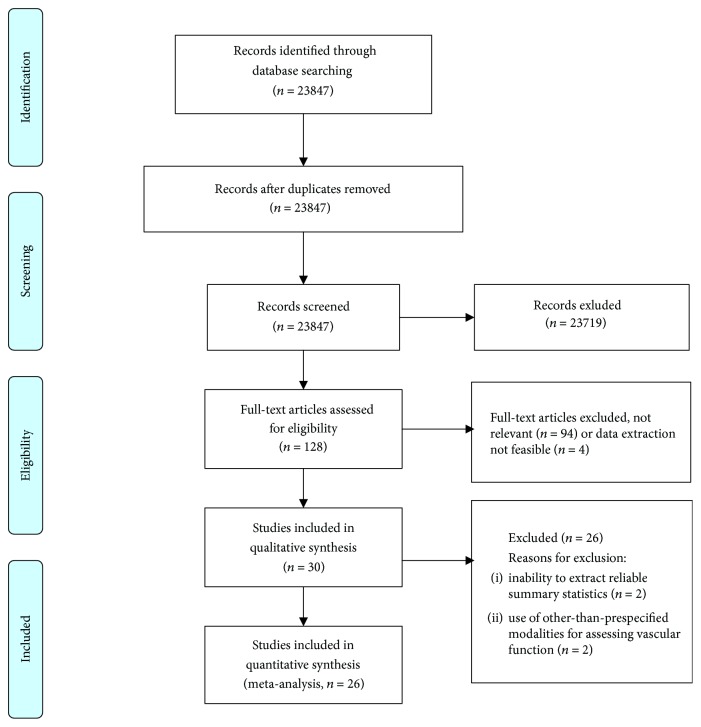
Study flow chart.